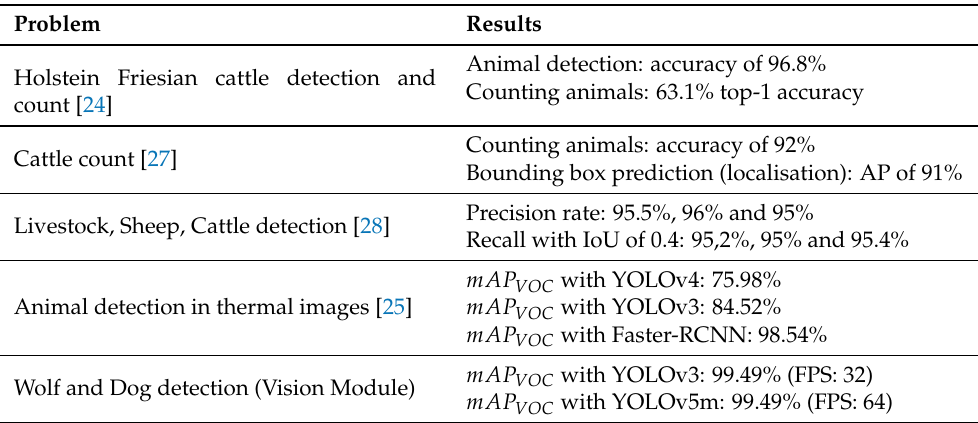
Table 2. Comparison of the state-of-the-art results with the proposed method for animal detection and count of different